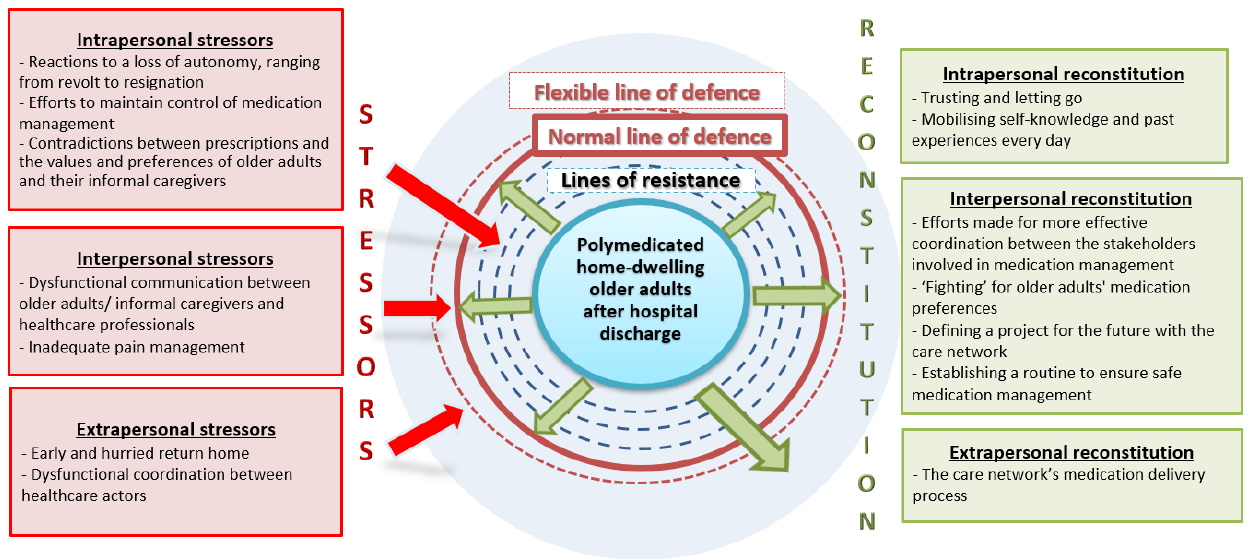
Figure 2. Stressors experienced and reconstitution strategies adopted by polymedicated home- dwelling older adults managing their medication after hospital discharge—inspired by the NSM [28].